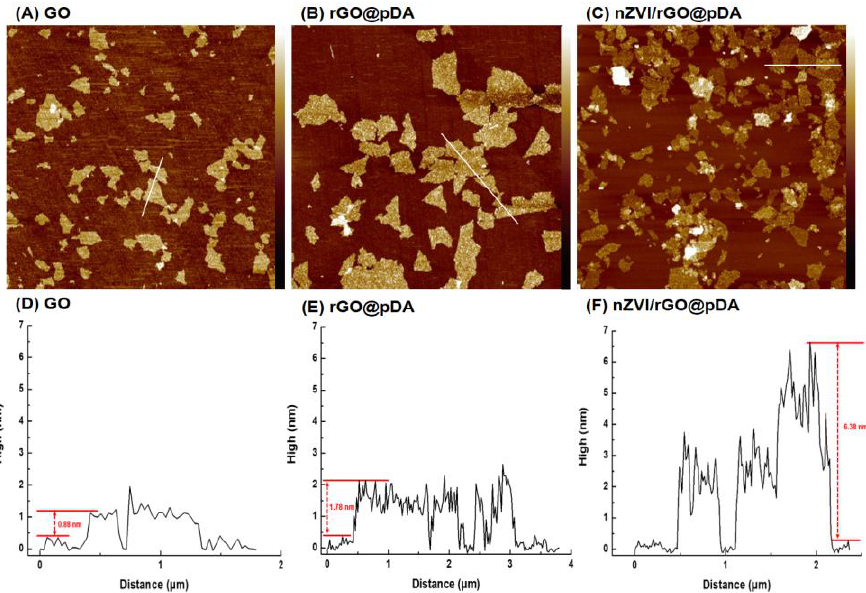
Figure 2. Representative tapping-mode atomic force microscopy images of preparations. Images show representative micrographs of ( A ) GO, ( B ) rGO@pDA, and ( C ) nZVI / rGO@pDA. Cross-section plots are also shown of ( D ) GO, ( E ) rGO@pDA, and ( F ) nZVI / rGO@pDA. Abbreviations: GO, graphene oxide; nZVI / GO, reduced graphene oxide modified with dopamine; nZVI / rGO@pDA, nano zero-valent iron immobilized on the surface of reduced graphene oxide then modified with dopamine.